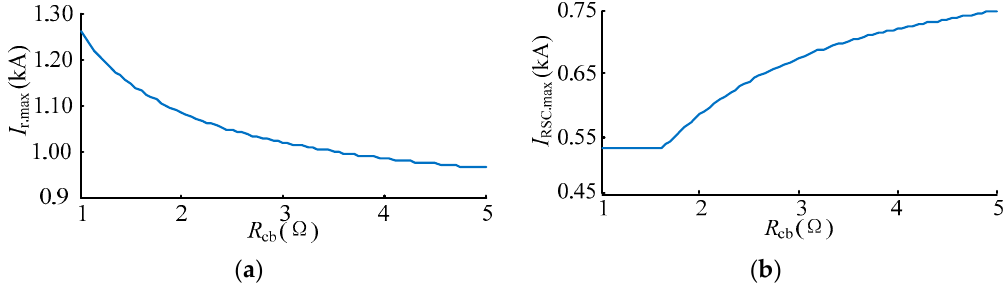
Figure 10. Calculation results under different crowbar resistors. ( a ) The maximum of the rotor current; and ( b ) the maximum of the RSC current.